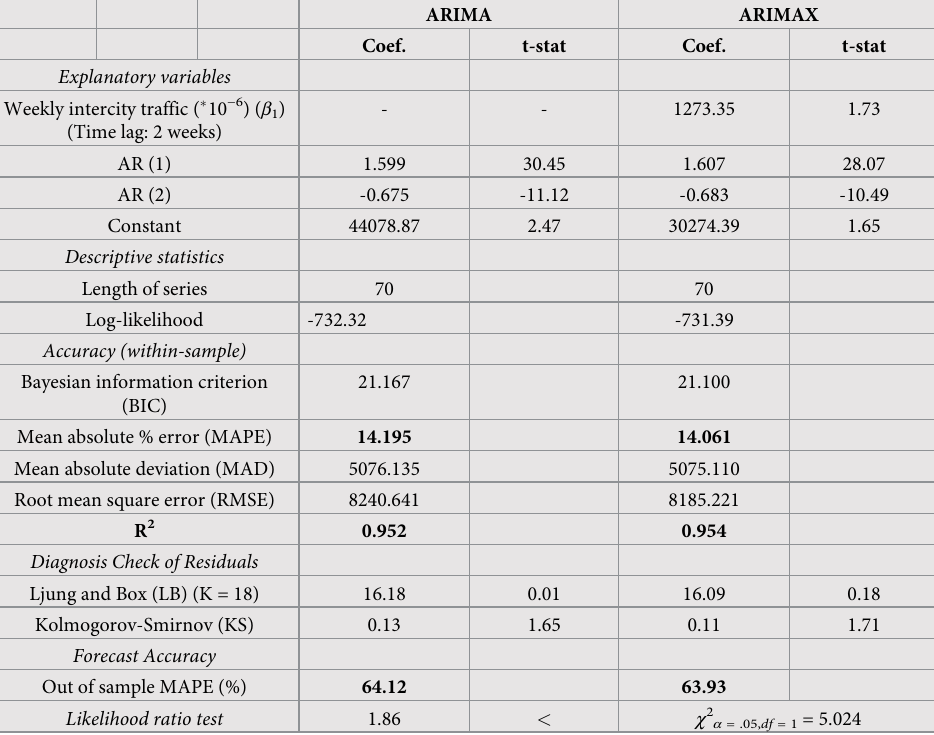
Table 4. Weekly new COVID cases forecasting models. ARIMA ARIMAX Coef.